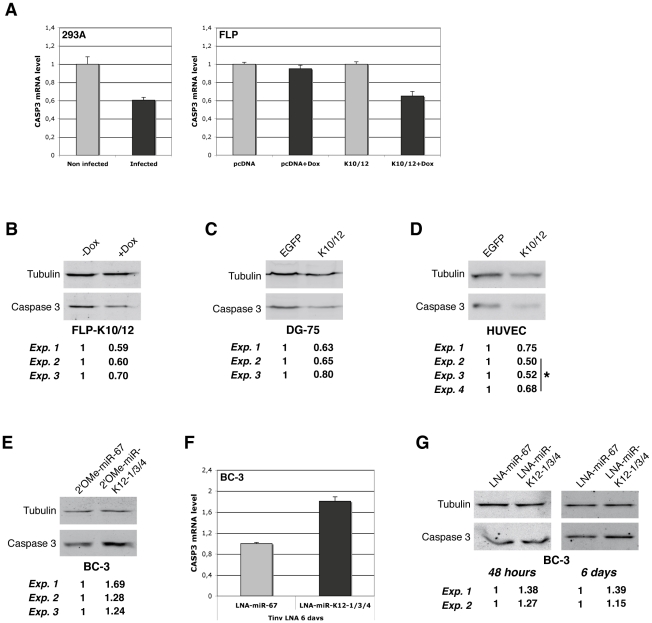
Endogenous Casp3 is regulated by KSHV miRNAs in different cell lines.
A. qRT-PCR analysis of Casp3 mRNA expression in non-infected vs. de novo KSHV-infected HEK293 cells (left panel), and in inducible FLP-pcDNA or FLP-K10/12 cells (right panel), by comparing the non-treated vs. doxycycline-treated conditions. Error bars represent the standard deviation observed for 3 technical replicates. B. Western blot analysis and signal quantification from three independent experiments for Casp3 and Tubulin on the inducible FLP-K10/12 cell line, non-doxycycline-treated vs. doxycycline-treated conditions, and C. DG-75 cells expressing either EGFP or the K10/12 miRNA cluster. D. Western blot analysis and signal quantification from four independent experiments for Casp3 and Tubulin on primary or E6/E7 HUVEC cells stably expressing either EGFP or the K10/12 miRNA cluster after lentiviral transduction and antibiotic selection. *indicates experiments done in E6/E7 HUVEC cells. E. Western blot analysis and signal quantification from three independent experiments for Casp3 and Tubulin on KSHV miRNA inhibited-BC-3 cells. Cells were transfected with a 2′-O-methylated oligonucleotide antisense to the control cel-miR-67 (2′OMe-miR-67), or with a mix of oligonucleotides antisense to miR-K12-1, K12-3, and K12-4-3p (2′OMe-miR-K12-1/3/4) at the same final concentration, and harvested 48 h later. F. qRT-PCR analysis of Casp3 mRNA expression in KSHV miRNAs inhibited-BC-3 cells by tiny LNAs treatment. Cells were incubated for 6 days with 8mer LNA-oligonucleotides antisense to the seed region of the control miR-67 (LNA-miR-67), or with a cocktail of oligonucleotides antisense to miR-K12-1, -3, and 4-3p (LNA-miR-K12-1/3/4) at the same final concentration. G. Western blot analysis and signal quantification from two independent experiments for Casp3 and Tubulin on the same cells treated with the indicated tiny LNAs for 48 h (left panel) or 6 days (right panel).